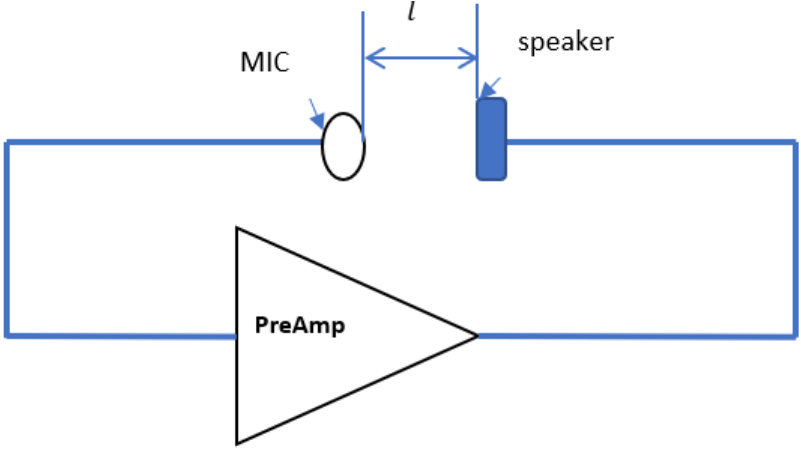
Figure 5. The block diagram of the resonance circuit.